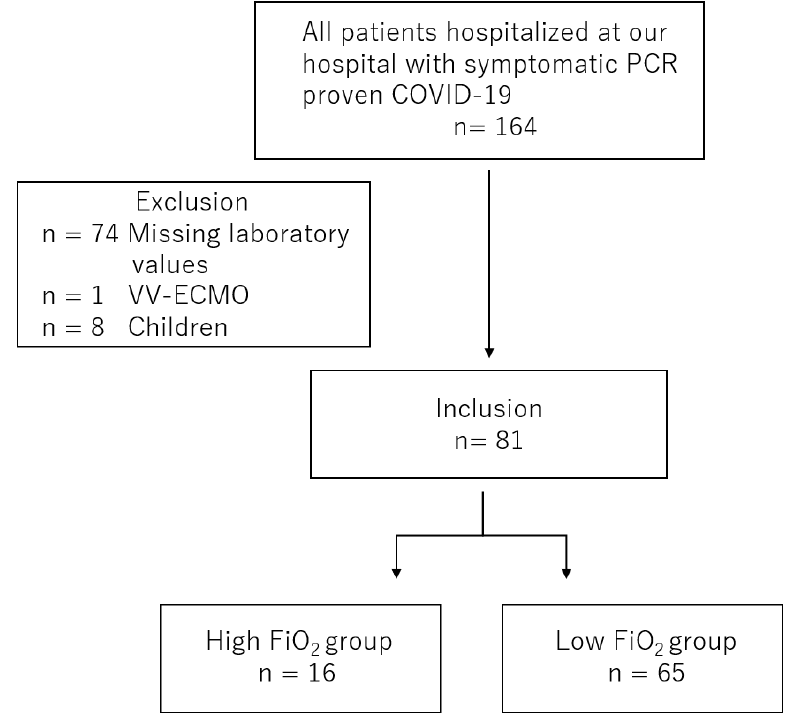
Figure 1. Study Figure 1. Study flow .